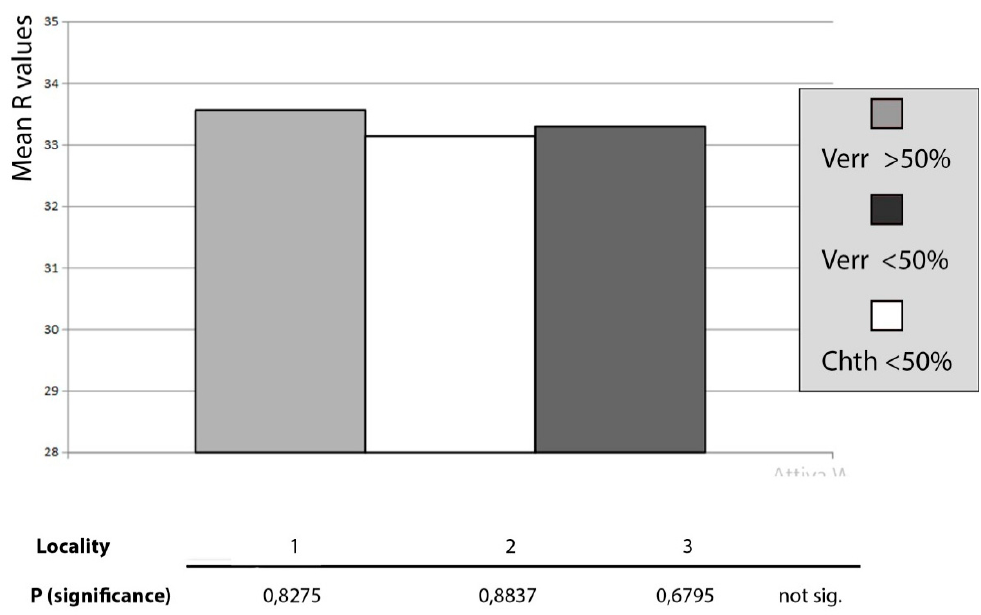
Figure 10. Mean rebound ( R ) values related to Chthamalus spp. and Verrucaria covers on Calafuria locality and significance ( P ) values related to different treatments and initial biota coverage.